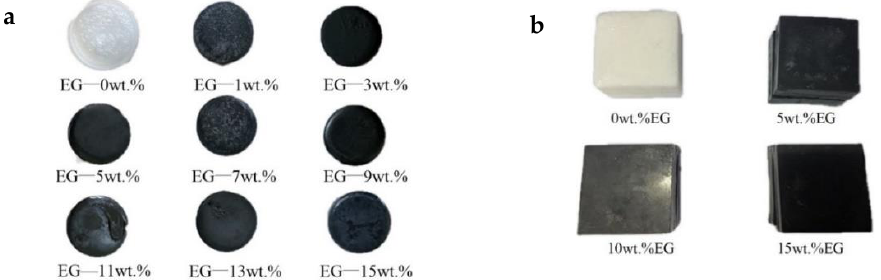
Figure 3. ( a ) DSC test samples; ( b ) Thermal conductivity test samples.